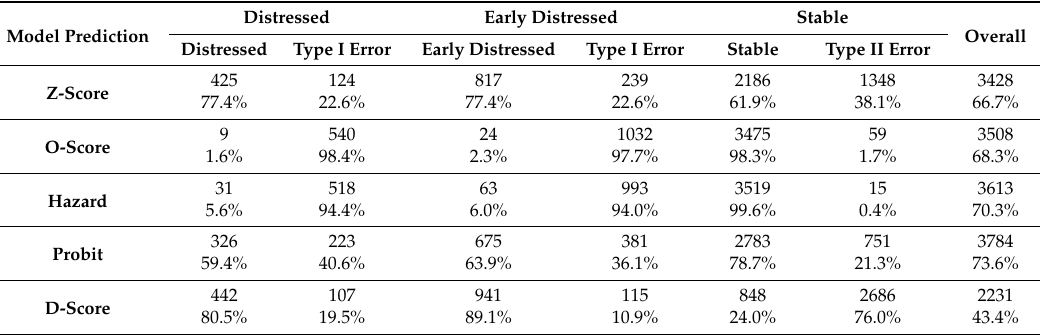
Table 10. Prediction accuracy of models with three stages of financial